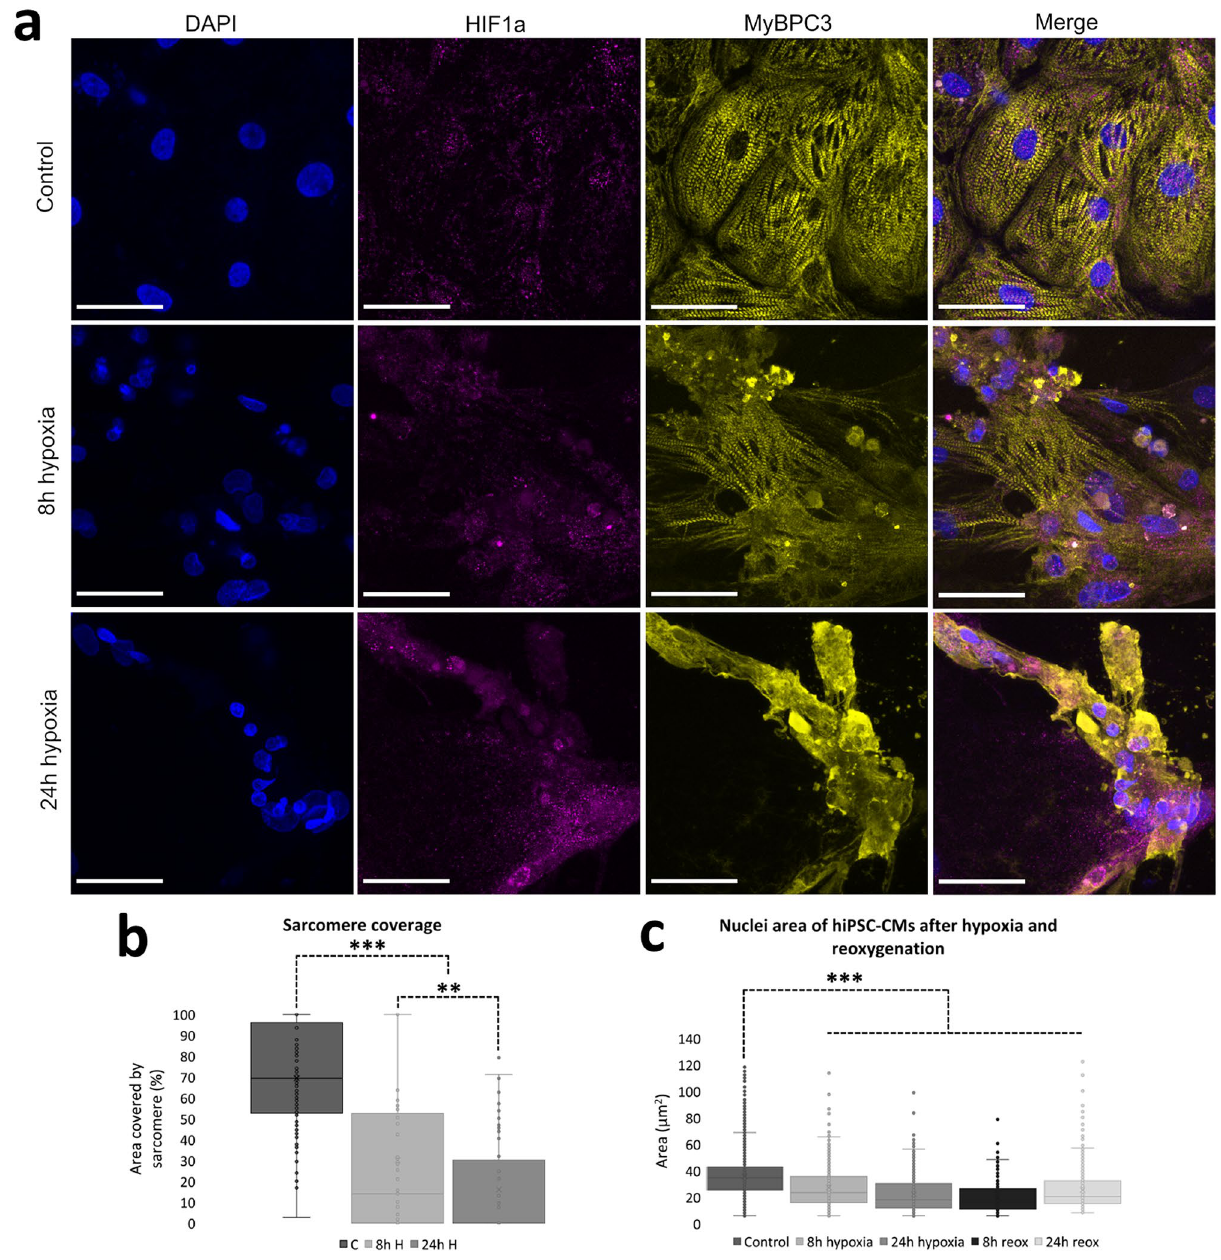
Figure 3. ( a ) The structure, sarcomere expression and nucleus size changes during hypoxia. Sarcomeres (MyBPC3, yellow) are clearly visible and the cells are spread and properly attached to the plate in control (n images = 124) samples, whereas the cell structure seems to deteriorate after 8 h (n images = 47) and 24 h (n images = 50) hypoxia. Furthermore, the nucleus (DAPI, blue) size seems to decrease. On the other hand, no significant changes are seen in the expression of hypoxia marker HIF1α (magneta). ( b ) Sarcomere coverage was quantified from the fluorescent images and calculated as the ratio between the area of visible sarcomeres to the total cell area and is expressed as percentage. The data are presented as mean + standard deviation. The expression of clear and visible sarcomeres decreases as the length of the hypoxia increases. ( c ) Area of the nuclei in control (n nuclei = 3632), 8 h hypoxia (n nuclei = 685), 24 h hypoxia (n nuclei = 833), 8 h hypoxia-reoxygenation (n nuclei = 329) and 24 h hypoxia-reoxygenation (n nuclei = 782) samples presented as mean + standard deviation. The area of the nuclei decreases with hypoxia and reoxygenation compared to control. **p < 0.01; ***p <